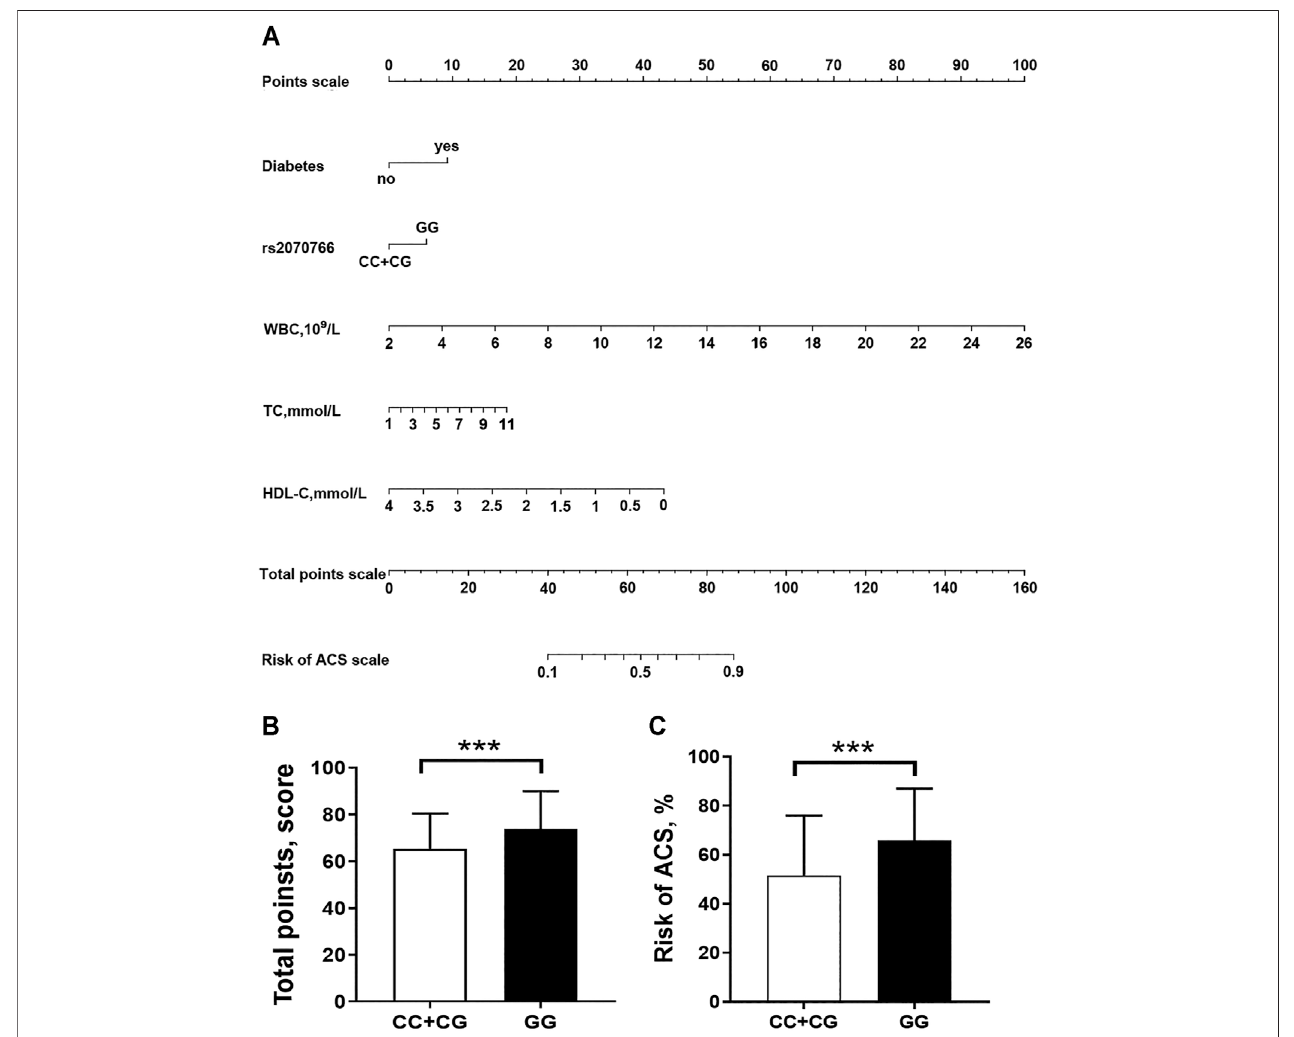
FIGURE3| NomogramtopredicttheriskofACS. (A) anomogramwasgeneratedbyusinganumberofclinicalvariablesincludingdiabetes,WBC,whitebloodcell count;TC,totalcholesterol;HDL-C,high-densitylipoproteincholesterol.(FigurewascreatedbyRsoftware,https://www.r-project.org/).Anindividualparticipantvalueis locatedoneachvariableaxis,andalineisdrawnupwardtodeterminethenumberof “ Pointsscale ” receivedforeachvariablevalue.Thesumofthesenumbersislocated onthe “ TotalPointsscale ” axistodeterminetheriskofACS. (B,C) ,comparisonsofthenomogramtotalpointsandriskofACSlevelsbetweenpersonswhocarrying CC + CG genotypes and GG genotype *** p < 0.0001.